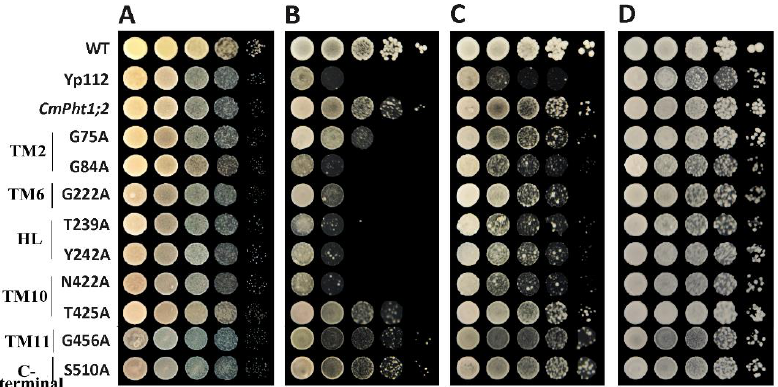
Figure 1. Sequences of 9 PTM mutation sites in CmPT2 phosphate transporter.